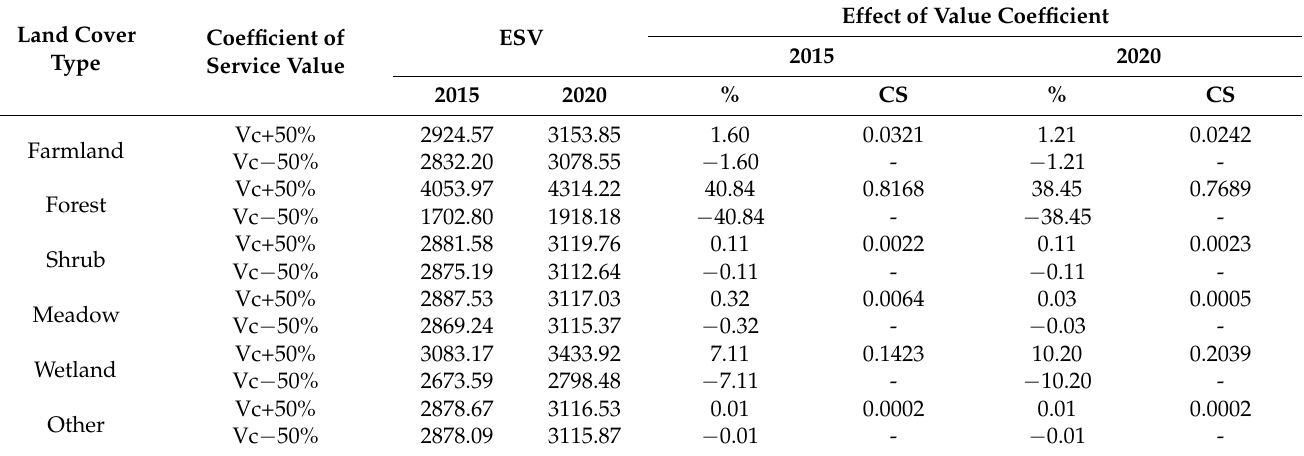
Table 9. The Sensitivity Coefficients in the SAHMHER during